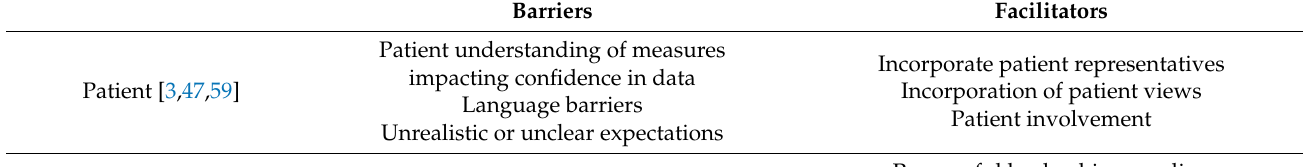
Table 4. Barriers to and facilitators of the use of collected PROM/PREM